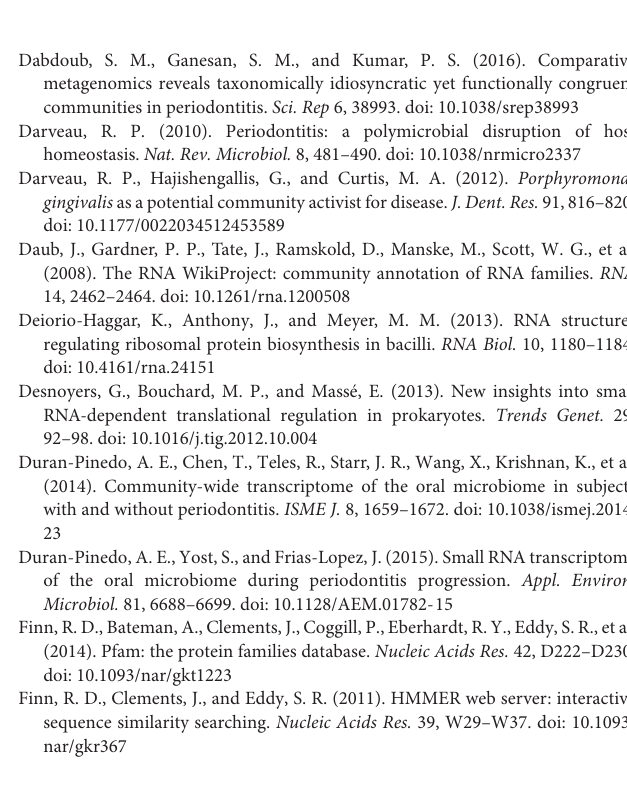
TABLE S1 | List of differentially expressed transcripts estimated form the pooled dataset spanning 48 healthy and 49 disease samples. A list of 859 DE